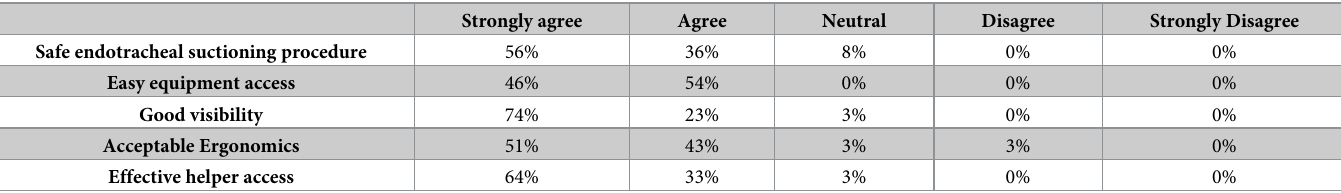
Table 1. Survey of medical staff performing intubation/extubation with enclosure on mannequins (n = 39). Strongly